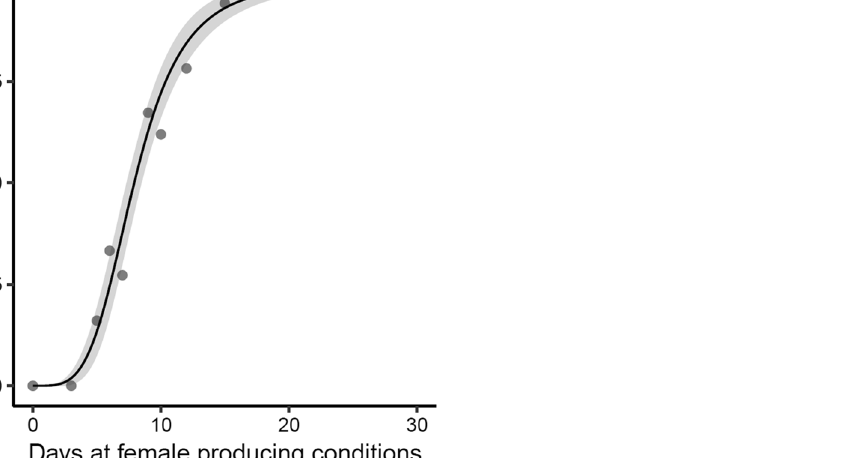
(Fig. 4), demonstrating that embryos from early and late season clutches possess different sex ratio reaction norms (Likelihood Ratio Test: χ 2 2 = 14.58, p = 0.0007), presumably as a result of the seasonal difference in maternal